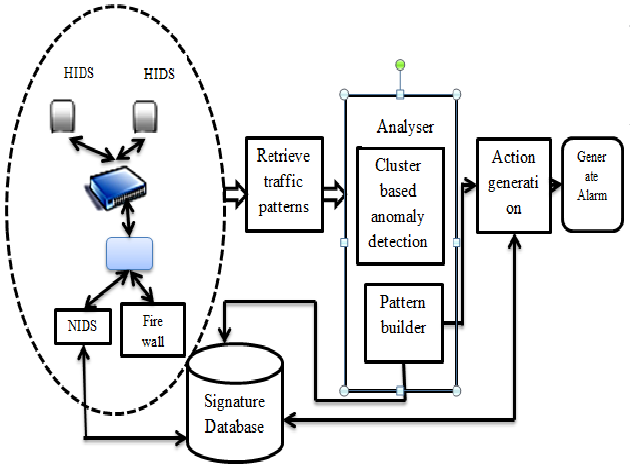
Figure 5. Mimicking Detection Algorithm at the server level